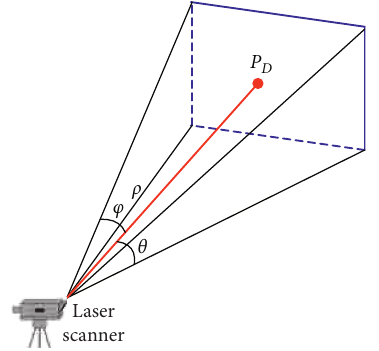
Figure 3: Scanning points construct quadricone